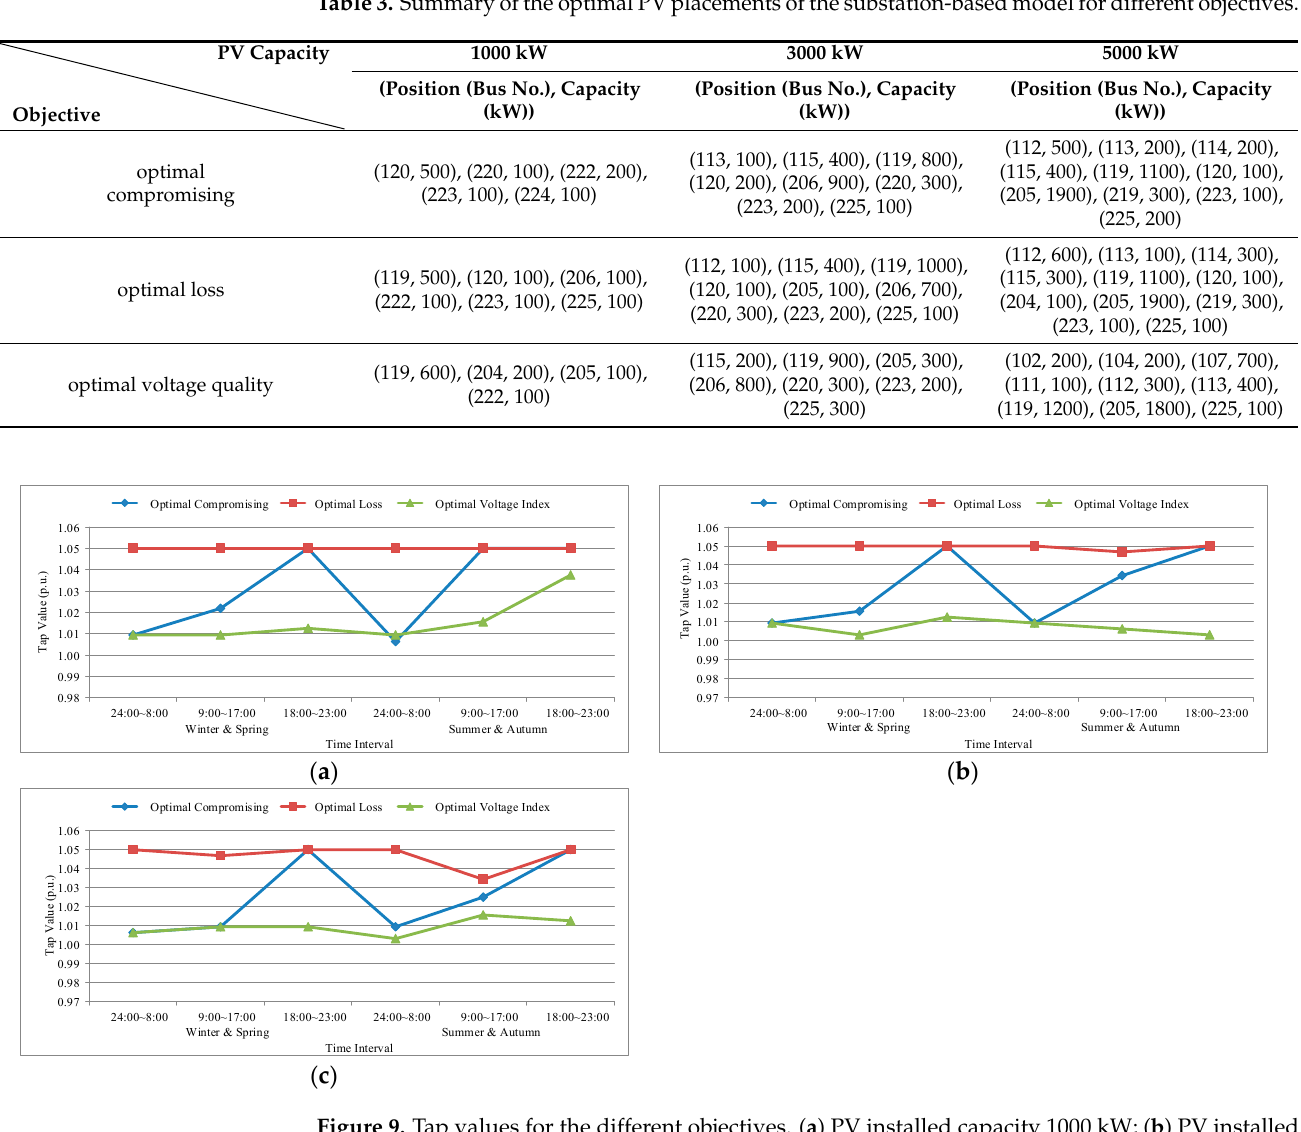
Table 3. Summary of the optimal PV placements of the substation-based model for different objectives.